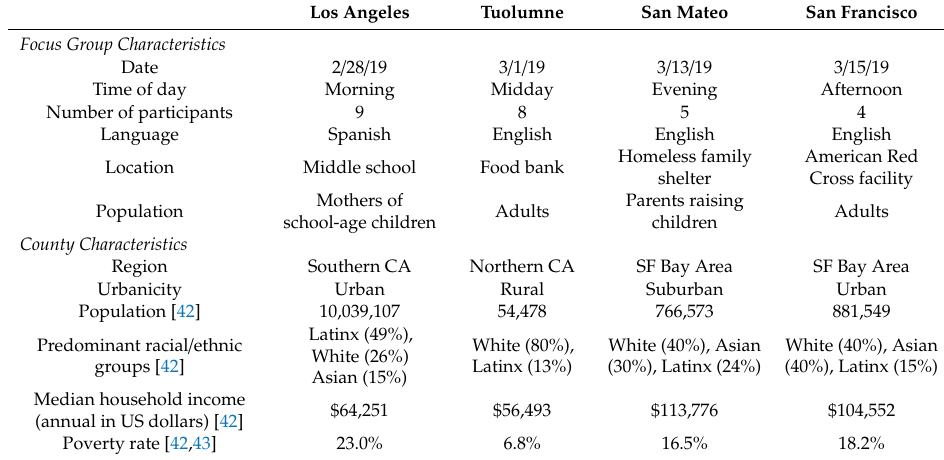
Table 1. Focus Group and County Characteristics. Description of focus groups conducted with SNAP participants in California to understand their experiences of the 2019 SNAP benefit